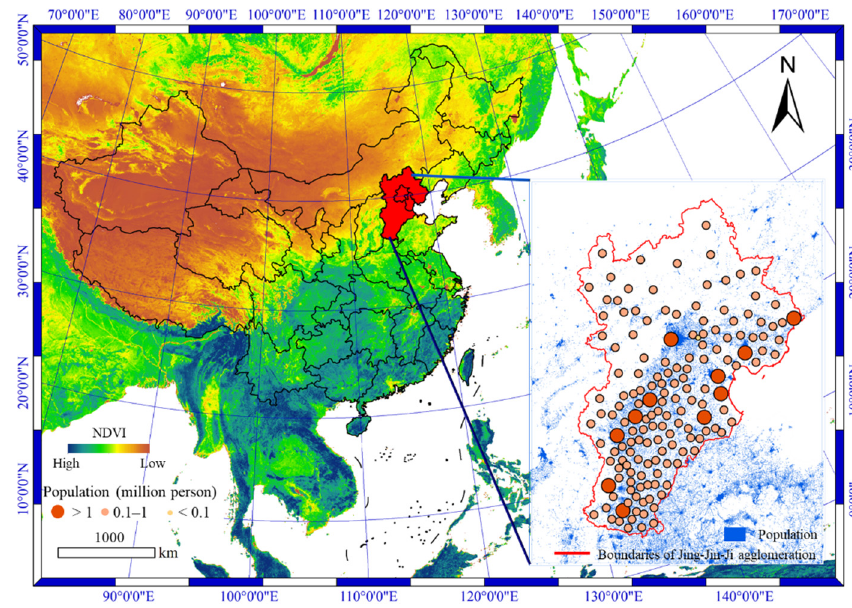
Figure 1. Geographical location of the research area and the scale of the cities.